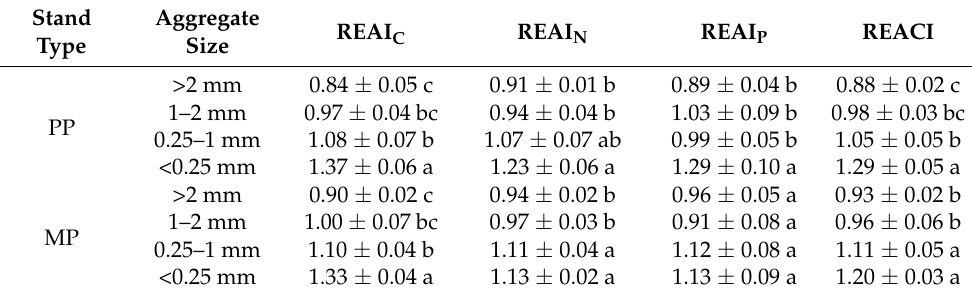
Table 3. Soil relative enzyme activity index (REAI) and relative activity comprehensive index (REACI) within soil aggregates in PP and MP (mean ± standard error, n = 5).